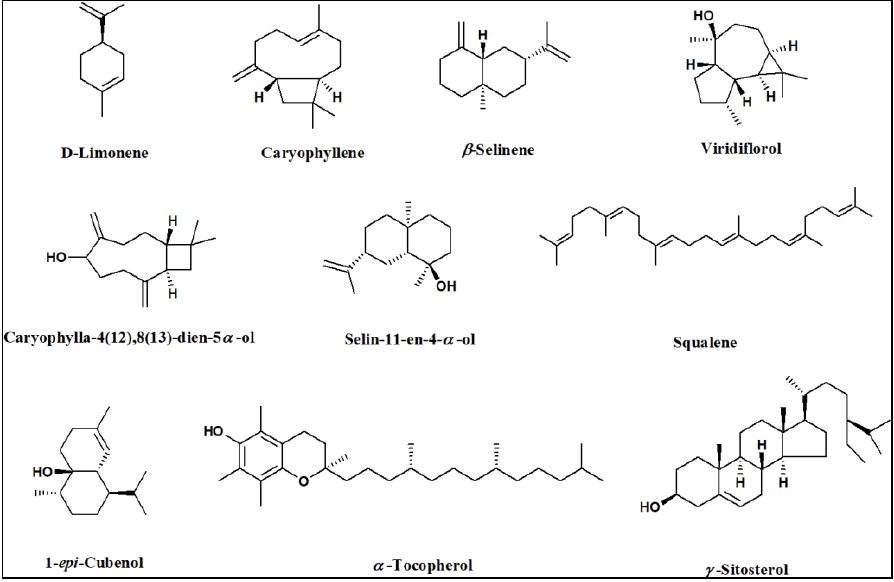
Figure 2. Chemical structures of the major constituents identified in the n -hexane extract and essential oil of Psidium guajava leaves using GC/MS